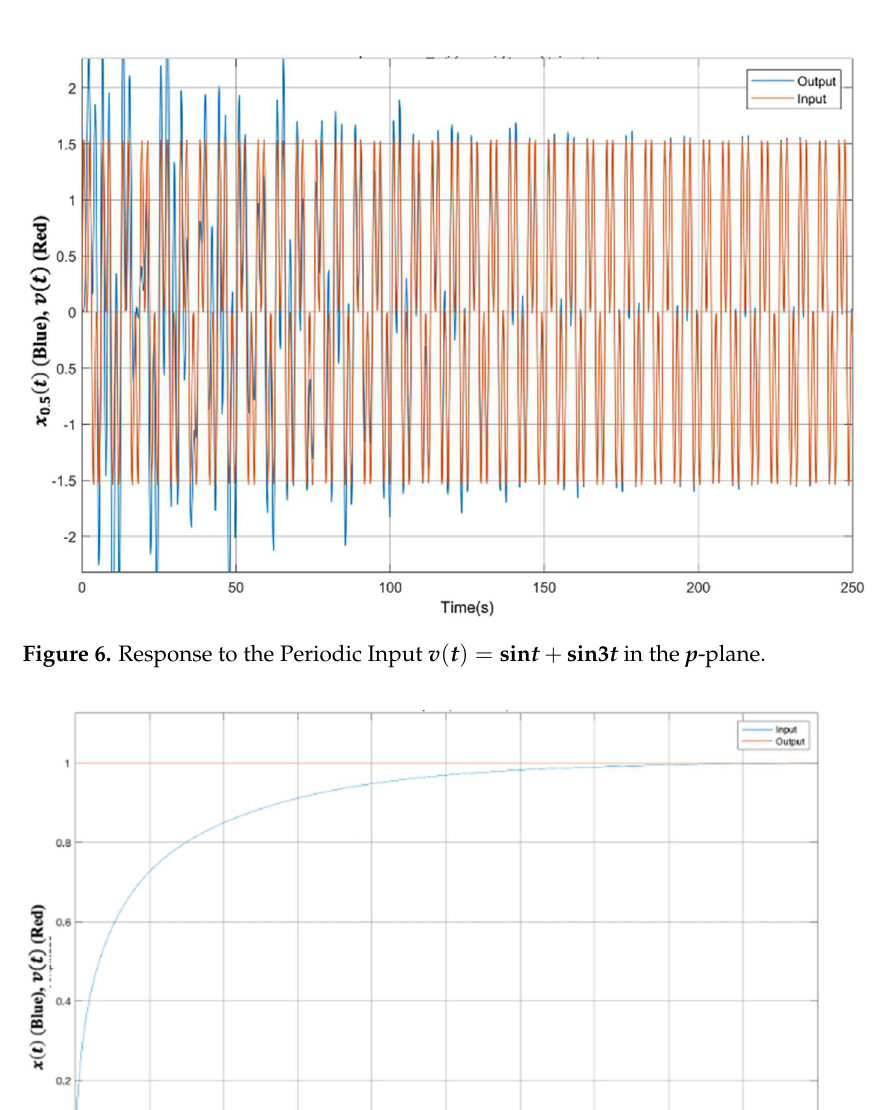
12 of 39 Figure 5. Response to a Step Input in the 𝒑 -plane. Note on Control Design: Initial simulations were conducted using control designs